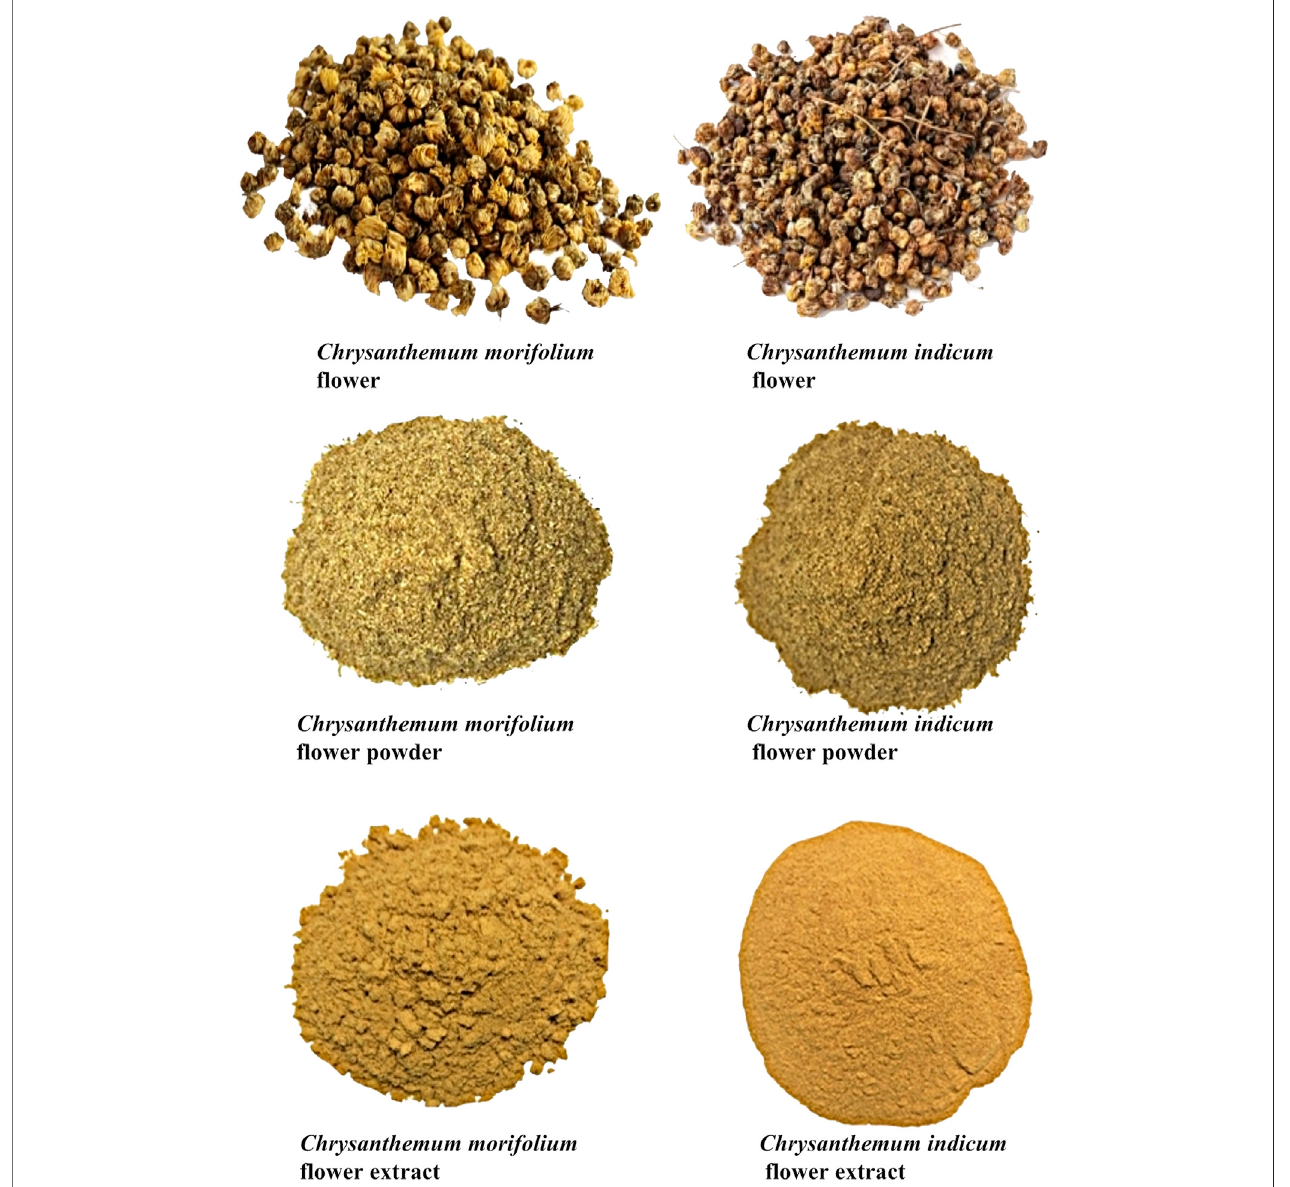
FIGURE 1 | Representative photos of C. morifolium fl ower and C. indicum fl ower.